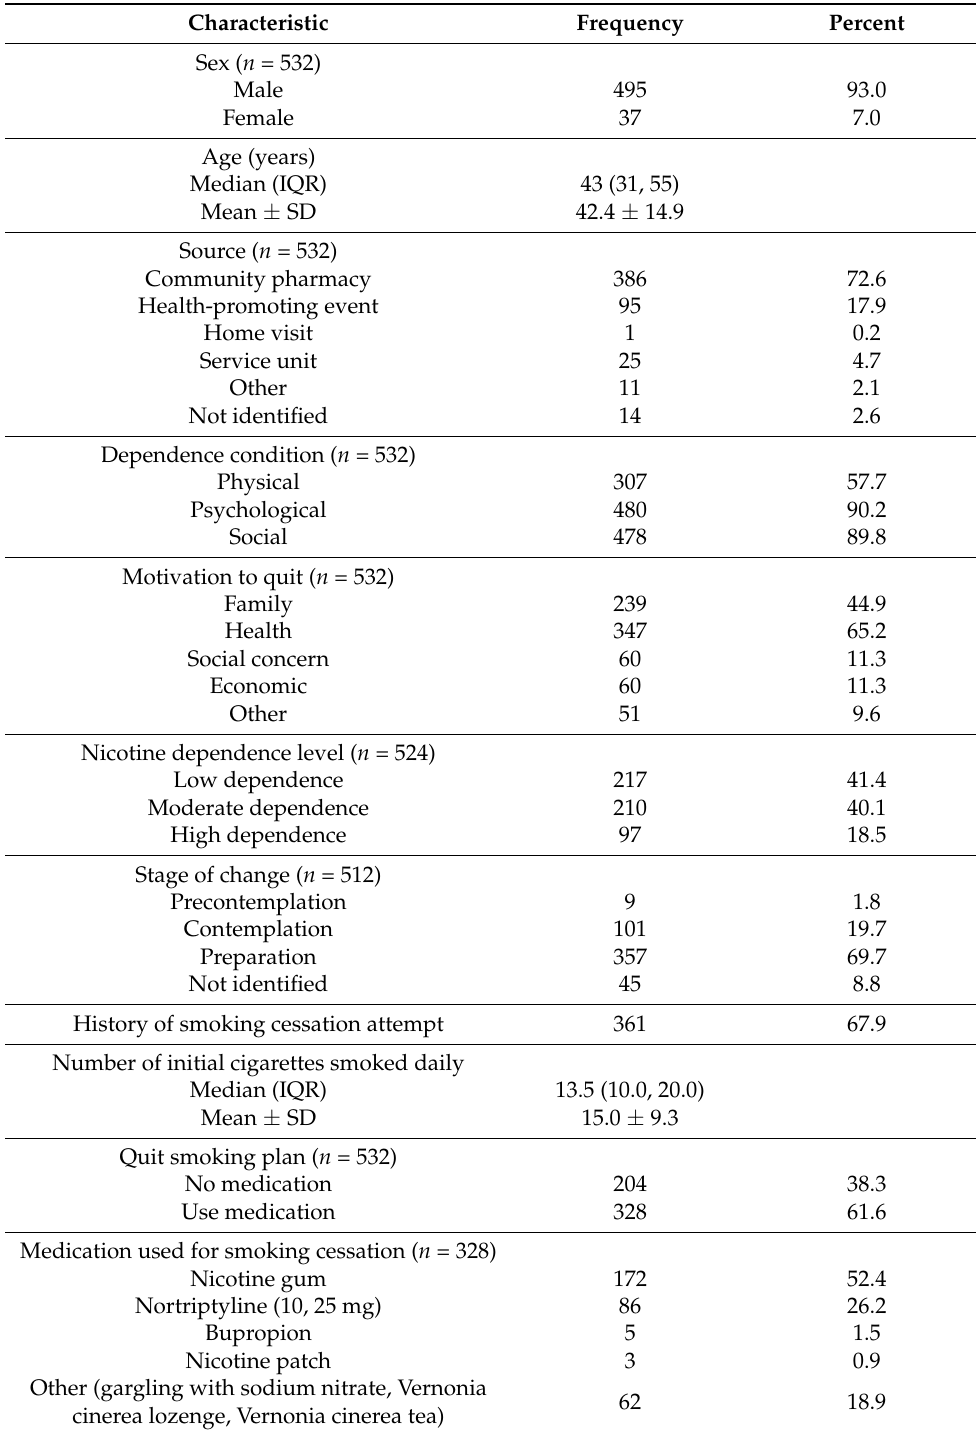
Table 1. Participant